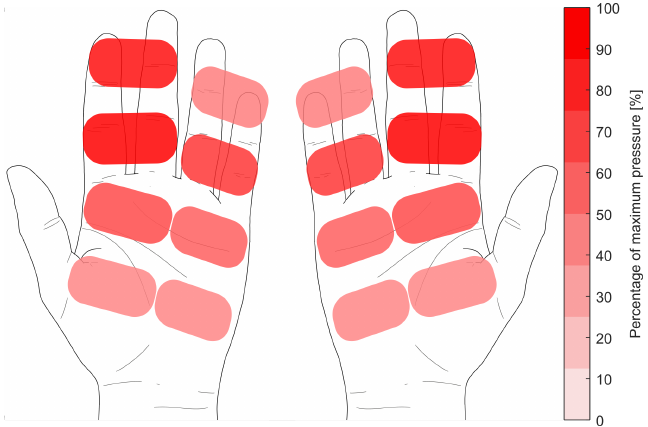
Figure 9. Pressure map of the rowers hands during the drive